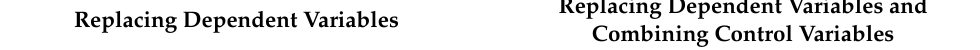
Table 4. Estimated results for substituting and combining